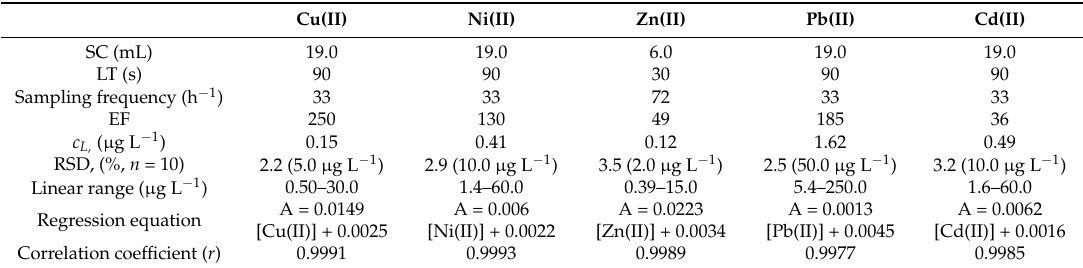
Analytical performance characteristics of the on-line FI-FDSE-FAAS method for metal